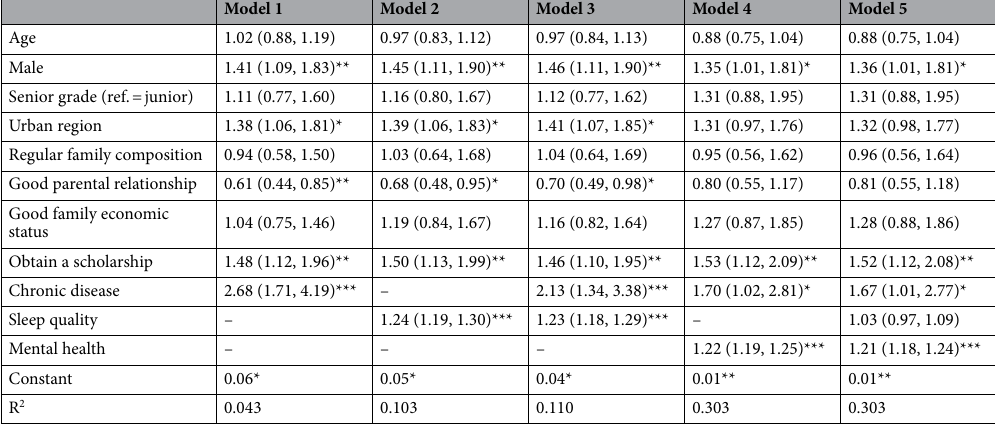
Table 2. Binary logistic regression for the factors associated with lifetime suicidal ideation (N = 2646). Only ORs and their 95% CIs were presented in the table. *p<0.05; **p<0.01; ***p<0.001.